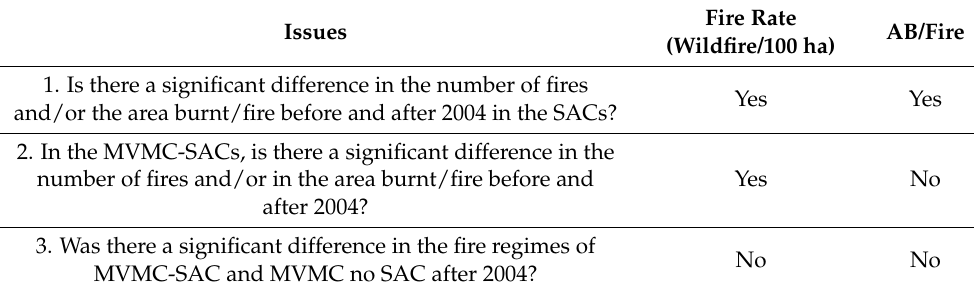
Fire Rate (Wildfire/100 ha)